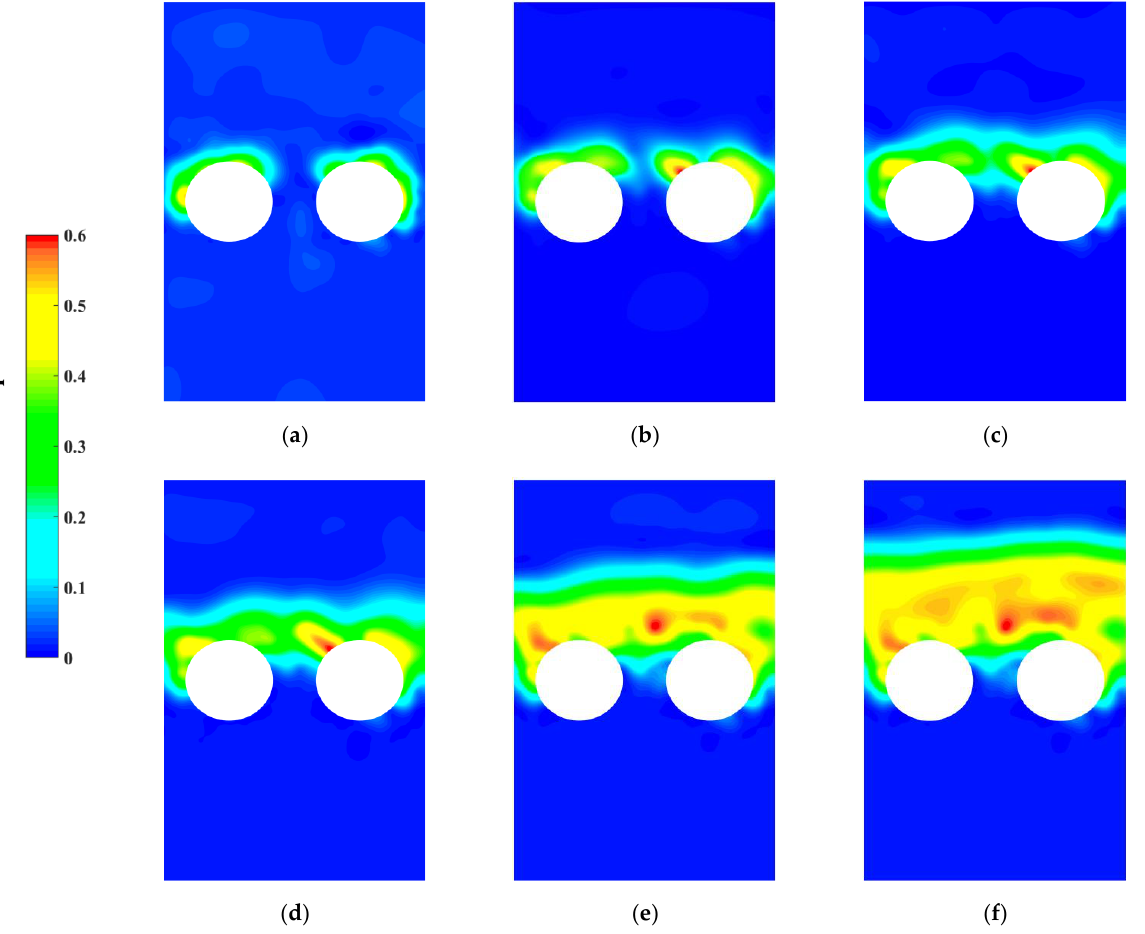
Figure 7. Cloud map of the volume fraction occupied by particles with time. ( a ) t = 1.5 ms; ( b ) t =